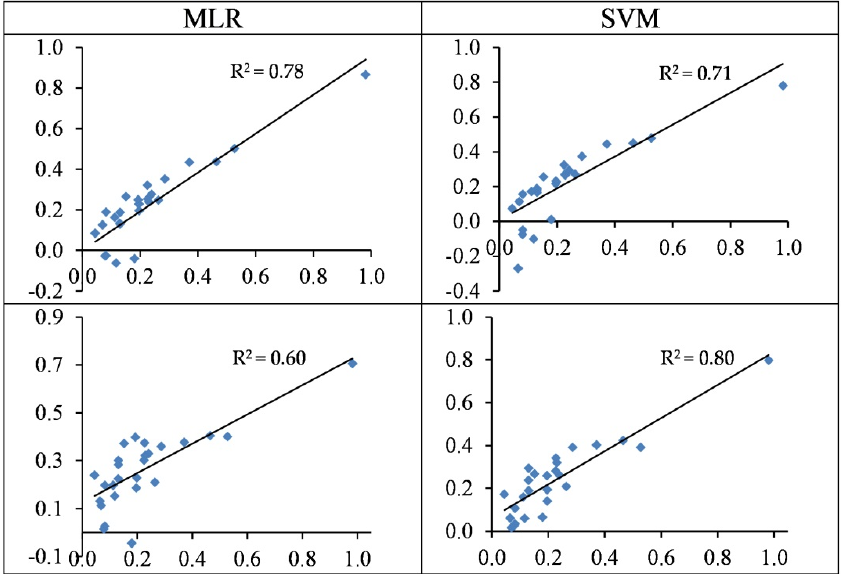
Figure 8. The standardized values (between 0–1) of the observed (horizontal axis) and the predicted (vertical axis) concentration of Cr based on wavelengths (top) and spectral indices (bottom) in the testing sets of the SVM and MLR methods.